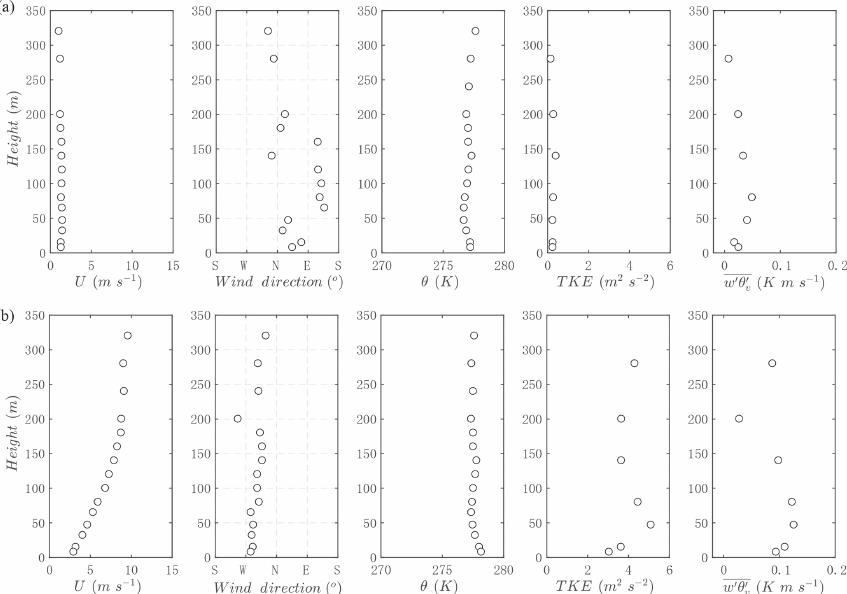
Figure 9. Vertical profiles of wind speed ( U ), wind direction (WD), potential temperature ( θ ), turbulent kinetic energy (TKE) and sensible heat flux ( w (cid:48) θ (cid:48) v ) measured at 12:00LT on 21 December 2016 (a) and 22 December 2016 (b) . Table 2. Averaged values of visibility (Vis), wind speed ( U ), relative humidity (RH), ABL height ( H c ), turbulent kinetic energy (TKE), friction velocity ( u ∗ ), momentum flux ( u (cid:48) w (cid:48) ) and sensible heat flux ( w (cid:48) θ (cid:48) v ) for different levels of pollution. Corresponding relationships between air pollution levels and PM 2 . 5 concentrations are as follows: good (0–75µgm − 3 ), slightly polluted (75–115µgm − 3 ),